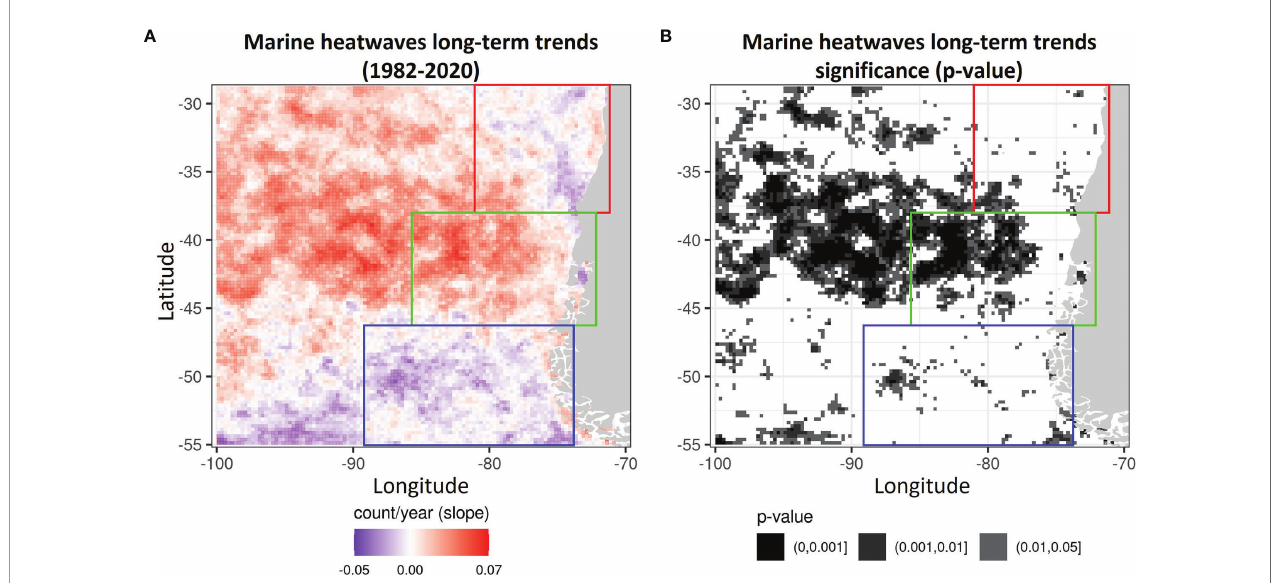
FIGURE 11 | Marine heatwaves (MHWs) trends (A) and signi fi cance of the trends according to the p-value (B) . The trend is calculated according to the number of MHWs that have occurred in each pixel from 1982 to 2020. Consequently, a positive (negative) trend signi fi cate that the number of MHWs is increasing (decreasing) with